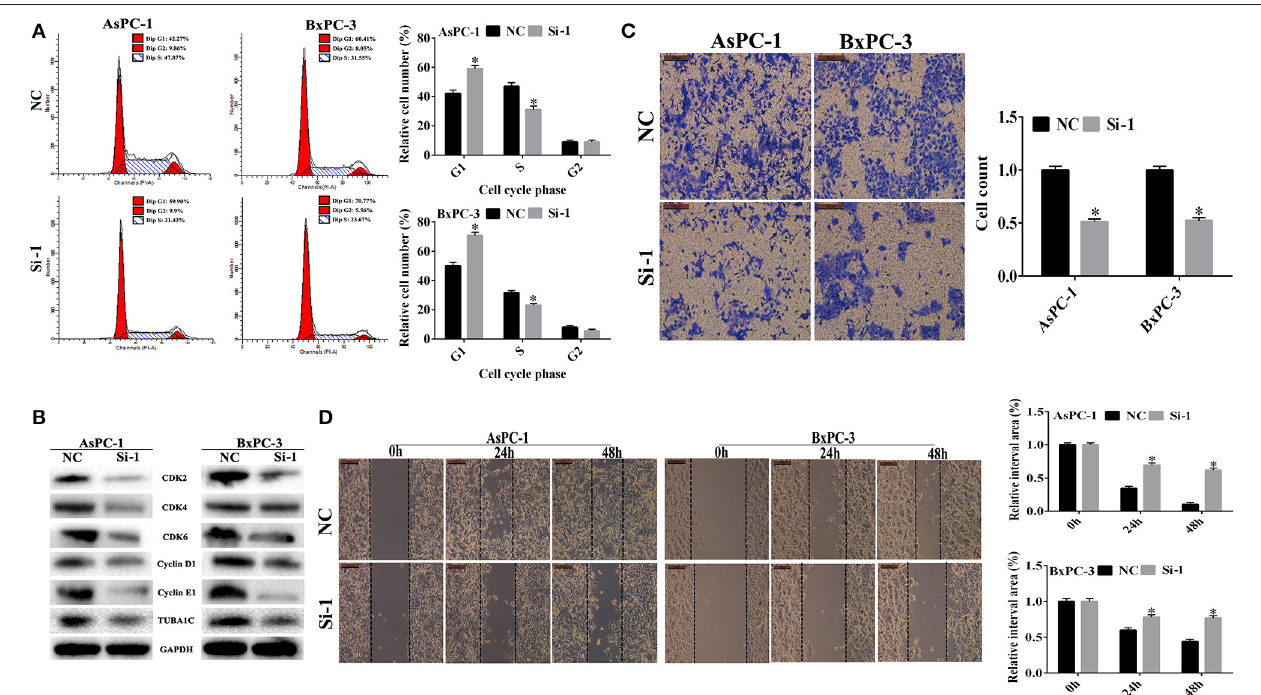
FIGURE 4 | The effect of TUBA1C knockdown on cell cycle, invasion, and migration in pancreatic ductal adenocarcinoma (PDAC) cells in vitro . (A) Cell cycle analysis using flow cytometry in AsPC-1 and BxPC-3 cells following TUBA1C knockdown. (B) Western blotting assay for cell cycle relative proteins. (C,D) Representative images of transwell assays and wound healing assay, and the quantitative result after TUBA1C knockdown in AsPC-1 and BxPC-3 cells. All results are displayed as the mean ± SD ( n = 3; * P < 0.05) compared with the negative control (NC)